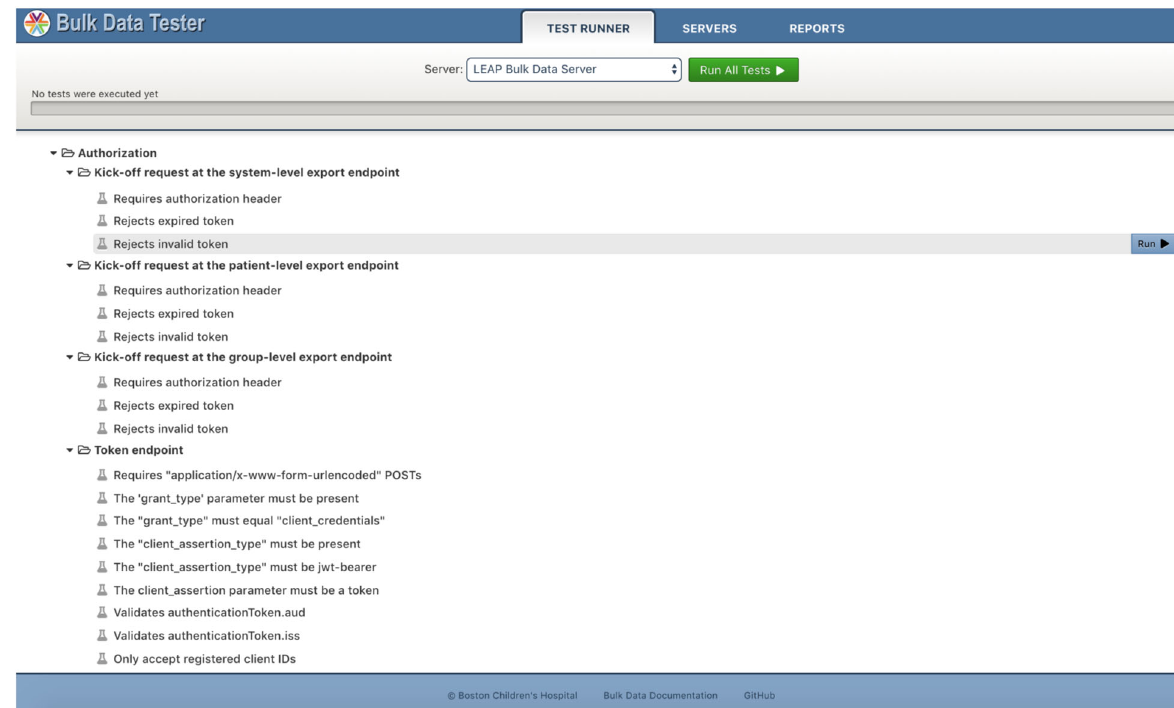
Fig. 5 Bulk Data testing tool. The open-source Bulk Data Tester hosts a suite of tests to con fi rm Bulk Data Access API conformance.